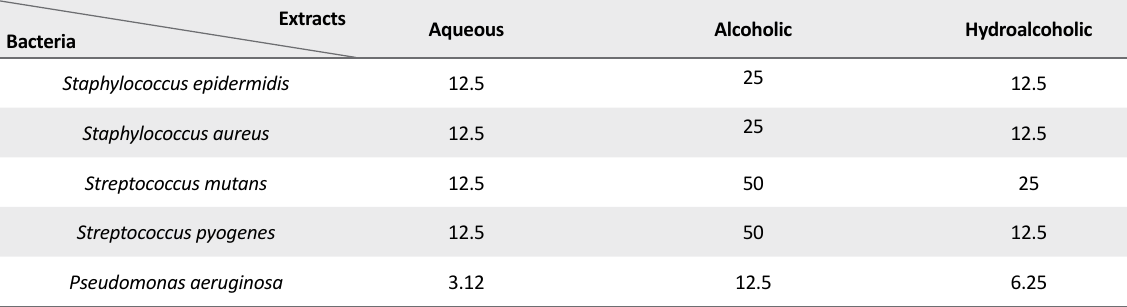
Table 3. MBC (mg/mL) of different extracts of Morus nigra fruit against the tested bacteria Extracts